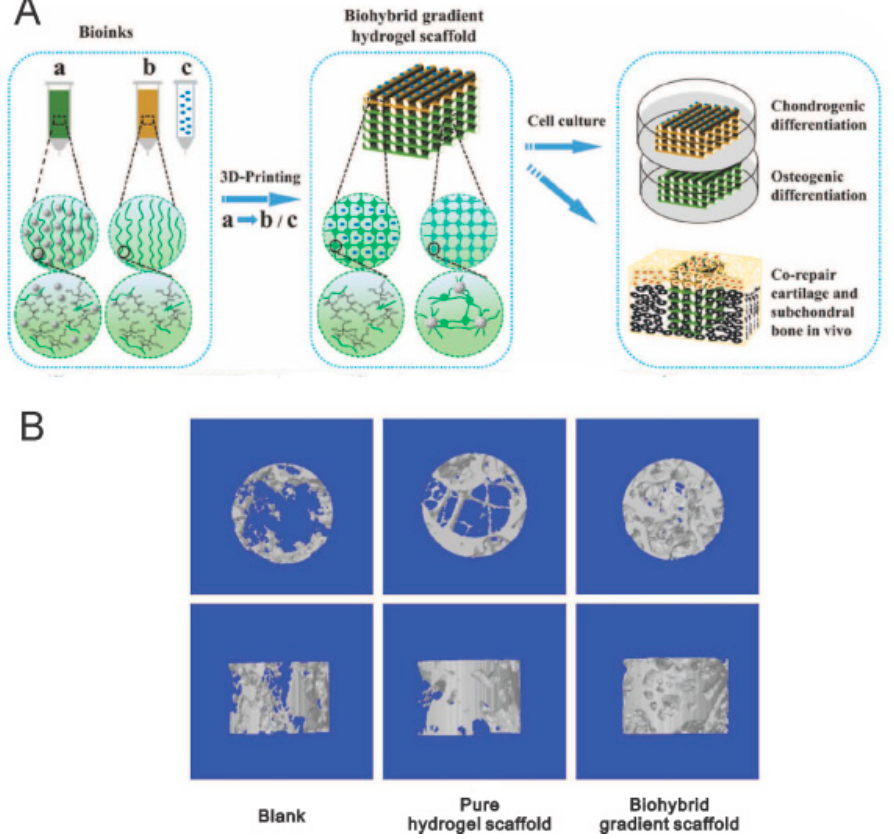
Figure 5. Bilayer hydrogel scaffolds with compositional gradients prepared by 3D printing for repair of osteochondral defect. ( A ) Schematic illustration of 3D printed biohybrid gradient scaffolds. ( B ) 3D printed gradient scaffolds stimulated cartilage and subchondral bone regeneration simultaneously in a rat osteochondral defect model. Reprinted from Reference [45].